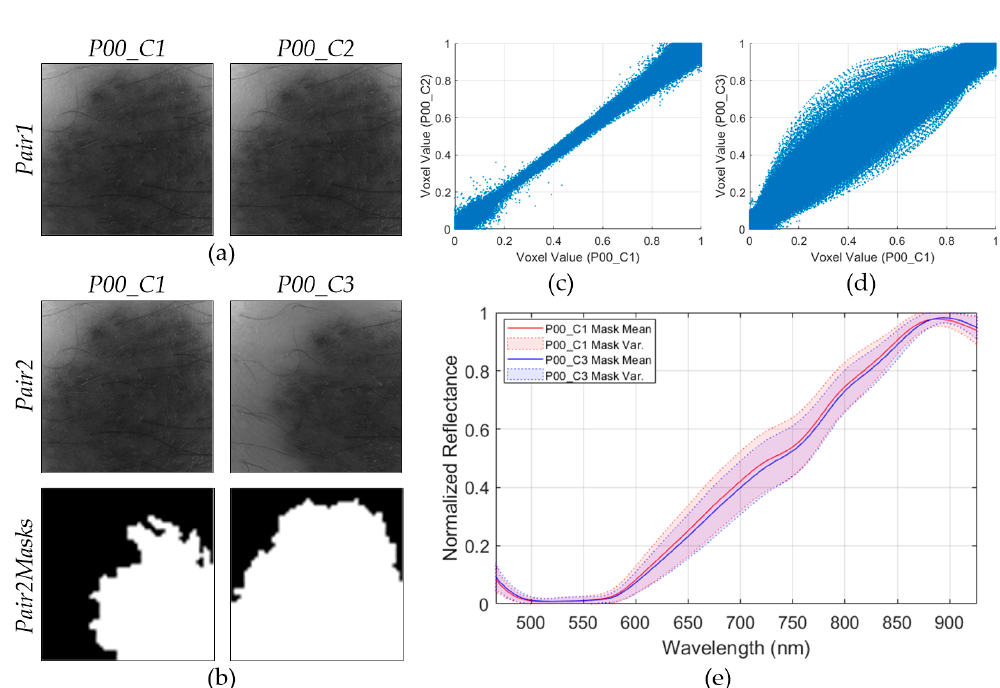
Figure 4. Repeatability results of the HS dermatologic acquisition system. ( a ) Gray-scale representation of the two consecutive HS images from the same PSL ( Pair1 ). ( b ) Gray-scale representation of the two HS images from the same PSL but captured in different spatial positions ( Pair2 ) and binary mask for the segmentation of the PSL pixels ( Pair2Masks ), where white pixels represent the PSL pixels. ( c ) Scatterplot of voxel values of Pair1 . Repeatability results: 𝑅𝐷 𝑚𝑒𝑎𝑛 = 9.52% . ( d ) Scatterplot of voxel values of Pair2 . Repeatability result: 𝑅𝐷 𝑚𝑒𝑎𝑛 = 23.68% . ( e ) Mean and variance of the segmented PSL pixels from Pair2 .